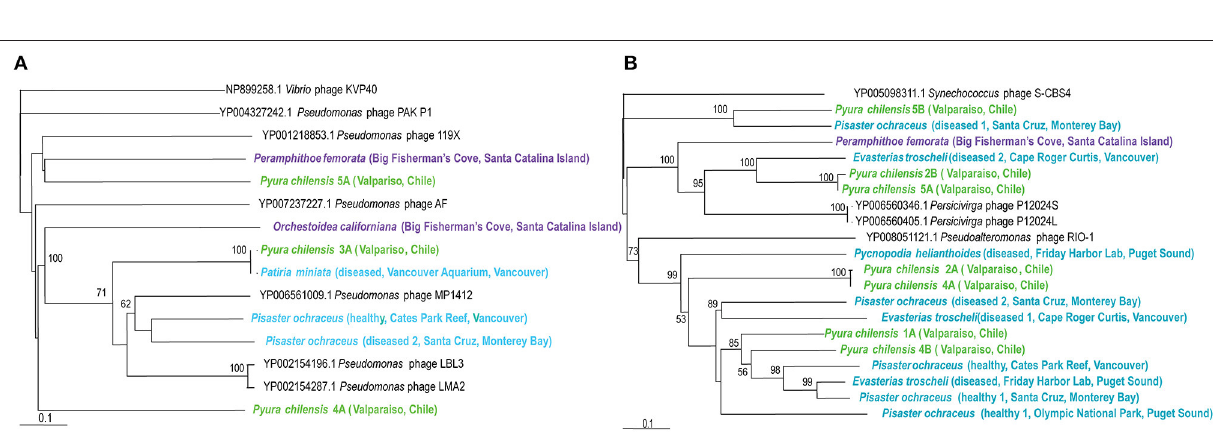
FIGURE 4 | Phylogenetic representation based on a 76 aa alignment of Phycodnavirus adenosylcobalamin-dependent ribonucleoside-triphosphate reductase protein, including closest relatives based on BLASTX comparison against the non-redundant database at the NCBI. The alignment was performed with CLUSTAL W and the tree drawn using neighbor joining. Bootstrap values of 1000 tree iterations that are > 50% are indicated at branch nodes. Scale bar represents 0.1 substitutions per site. The phyla are color-coded: blue are echinoderms, green are urochordates.